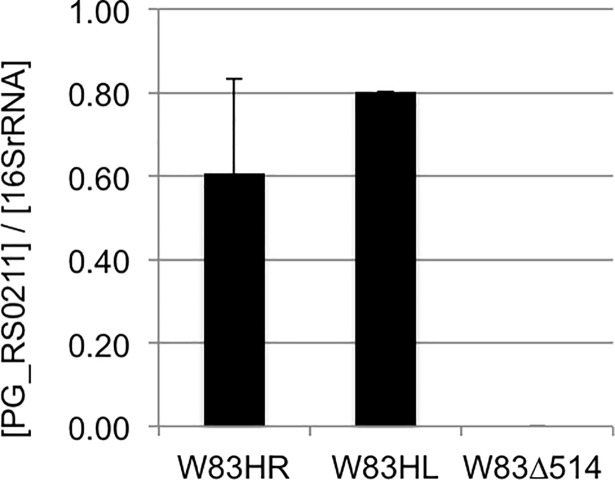
PG_RS02100 RNA expression.The data is reported as a ratio of the relative concentration of PG_RS02100 transcript divided by the relative concentration of 16S transcript within each total RNA sample. Student t-test suggests there was no statistical difference (p-value = 0.347) in the relative concentration of PG_RS02100 in W83 between HL or HR growth conditions at log-phase. Expression of PG_RS02100 was not detected in W83Δ514.